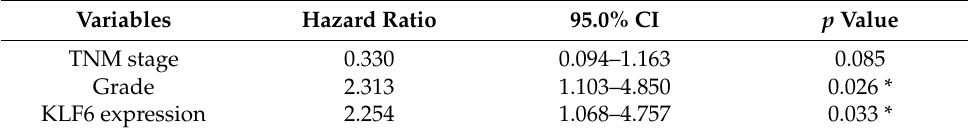
Table 3. Multivariate Cox proportional hazards analysis for survival of PAAD patients.